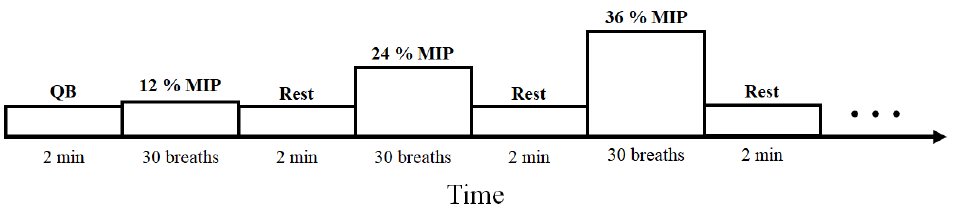
Figure 2. The inspiratory threshold loading protocol. After two minutes of load-less quiet breathing (QB), the load values, expressed as percentages of the maximal static inspiratory pressure (MIP), are progressively increased. Each loading task is followed by two minutes of